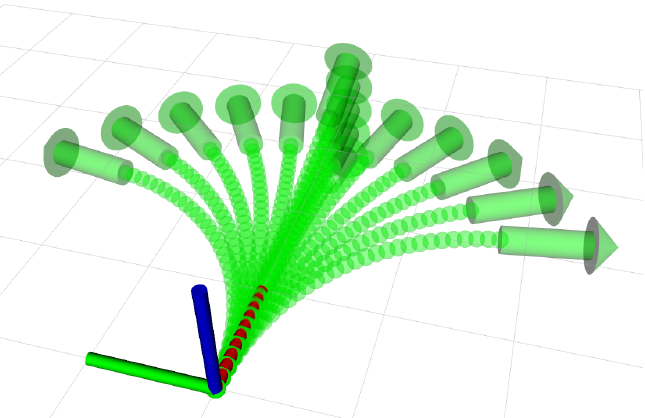
Figure 2. A set of motion primitives in SE ( 3 ) is constructed using the kinematic model of a bicycle. This is a discrete representation of the robot’s motion capabilities. The set of motion primitives consists of 1 straight path, 10 curvatures in the horizontal plane and 4 in the